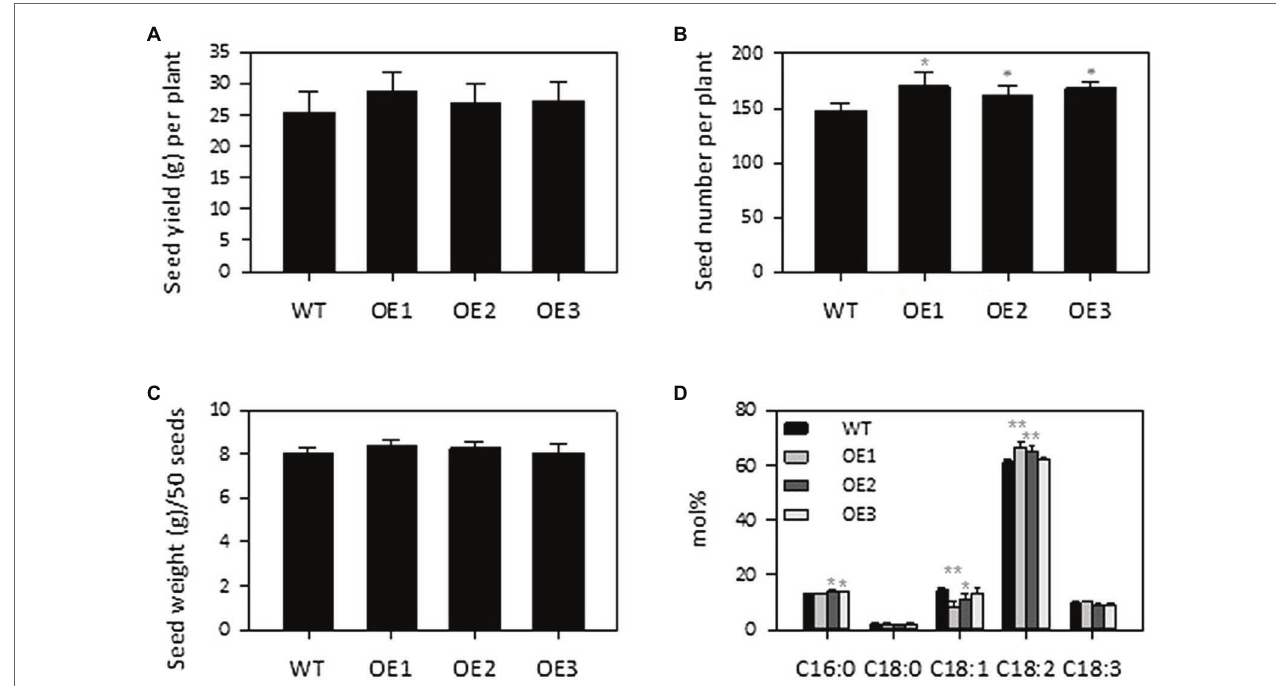
FIGURE 6 | Effect of PLD ε alterations on seed yield (A) , seed number (B) , 50-seed weight (C) and fatty acid composition of seed oil (D) . The seeds were harvested from WT and AtPLD ε OE soybean grown on normal soils in greenhouse ( n = 6 plants). The values are means ± SD. *Denotes statistical significance at p < 0.05 and **denotes statistical significance at p < 0.001 compared with WT as determined by one-way ANOITA (Duncan’s multiple range test).